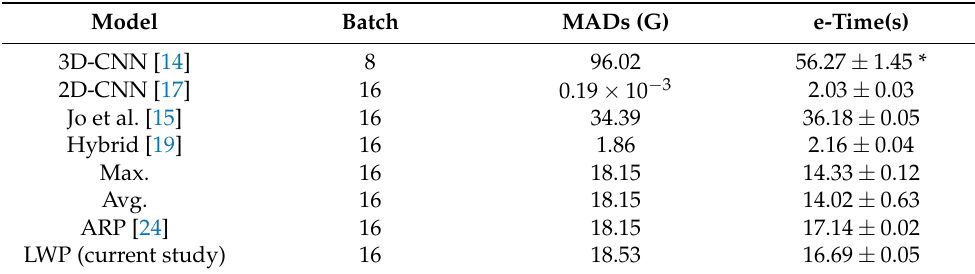
Table 5. The training computation cost of different 2D and 3D CNN models on PET image. Asterisk (*) indicates the largest value of the epoch time (e-Time).